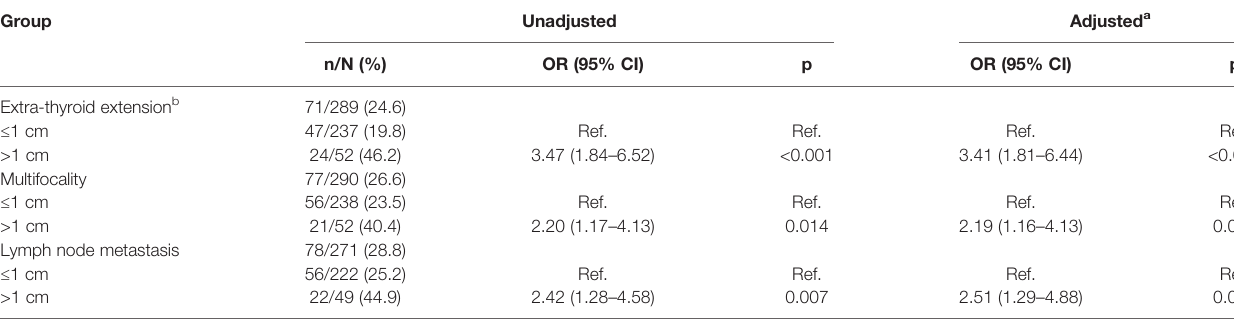
TABLE 3 | Logistic regression analysis of factors of PTC with different tumor sizes.